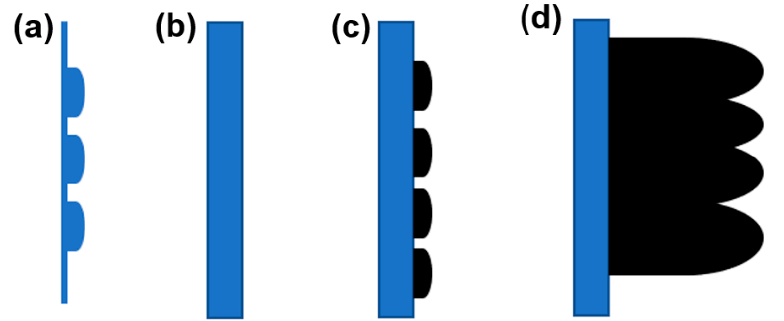
Figure 13. Diagram of secondary Widmanstätten sideplates growth. ( a ) GB ferrite nucleates at GBs,